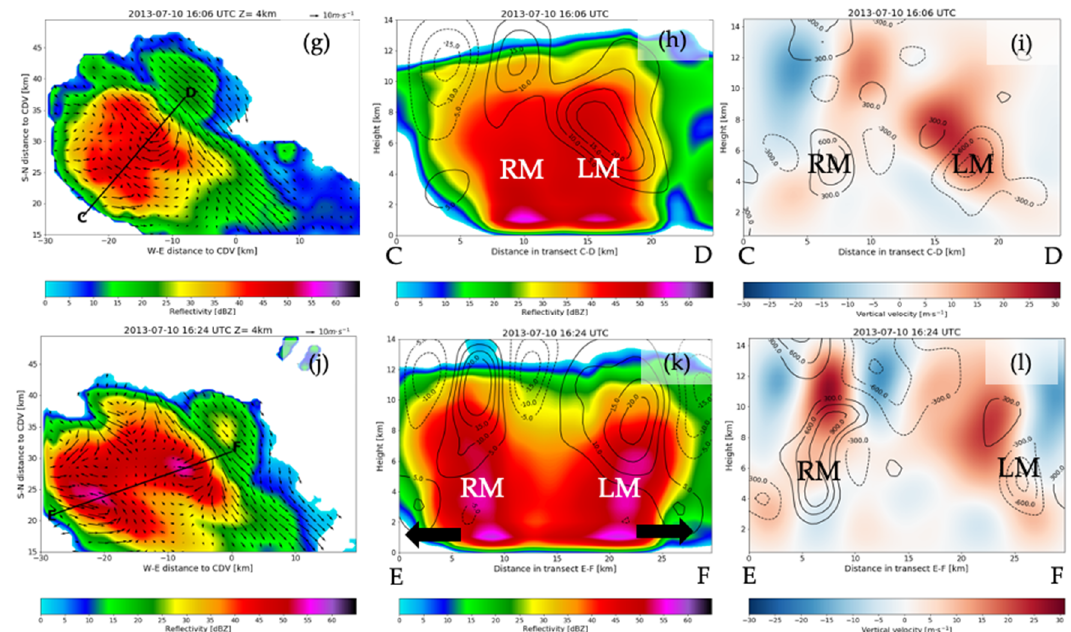
Figure 14. Retrieved reflectivity (in dBZ) and horizontal wind field (arrows) at 4 km for the storm on July 10, 2013: ( a ) 15:48 UTC, ( d ) 15:54 UTC, ( g ) 16:00 UTC, and ( j ) 16:24 UTC. Reflectivity and vertical wind cross section with contour lines indicating positive (solid) and negative (dashed) vertical velocity ( w , in m · s − 1 ): ( b ) 15:48 UTC, ( e ) 15:54 UTC, ( h ) 16:00 UTC, and ( k ) 16:24 UTC. Vertical velocity ( w , in m · s − 1 ) along the transect, with lines indicating positive (solid) and negative (dashed) vertical vorticity ( ζ , in 10 − 5 s − 1 ): ( c ) 15:48 UTC, ( f ) 15:54 UTC, ( i ) 16:00 UTC, and ( l ) 16:24 UTC. The thick black arrows indicate the direction of motion of the two resulting supercells.